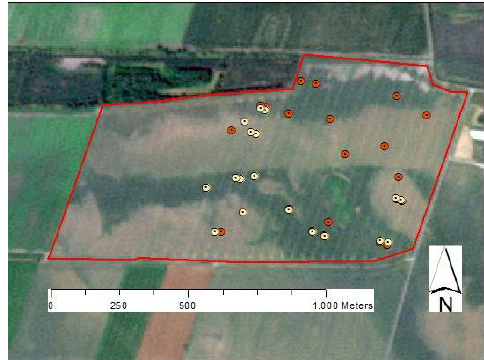
Figure 1. Test site with the sampling locations measured on 8th of May (dark points) and 27th of June 2011 (light points). The background image from the 27th of June shows the early ripening areas in brownish